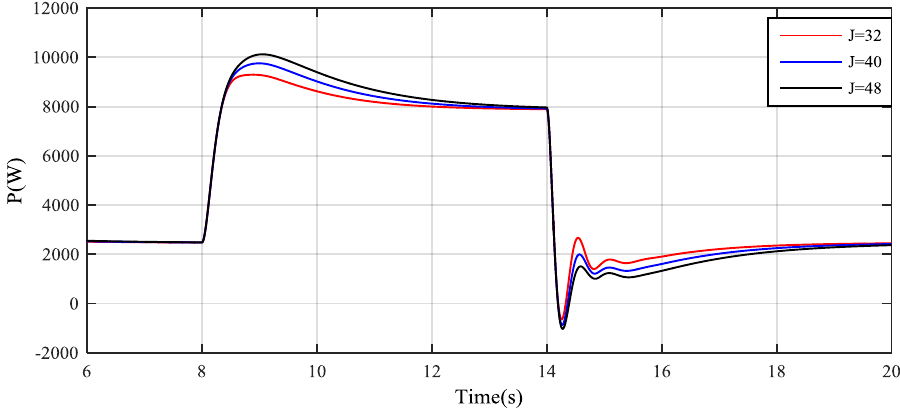
Figure 15. Active power of grid-forming converter with different virtual inertia.